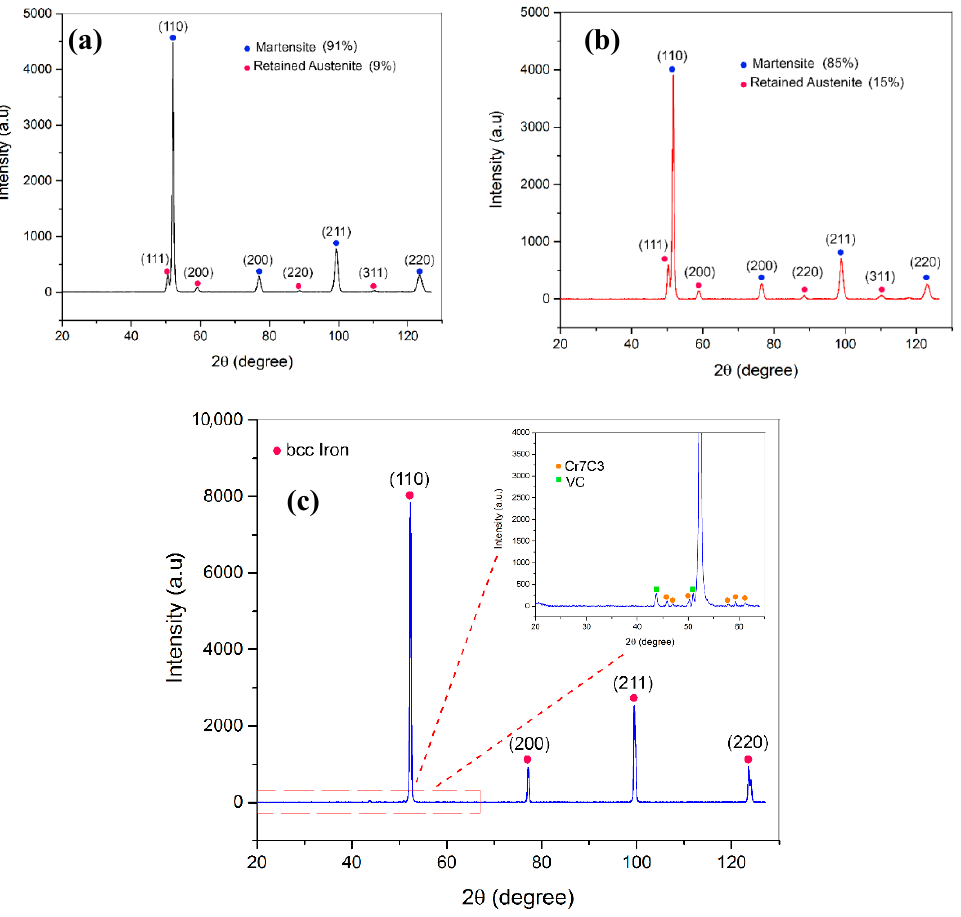
Figure 11. XRD analysis: ( a ) Sample C9 without preheating; ( b ) sample PC9 with 200 °C preheating; and ( c ) as-cast sample.